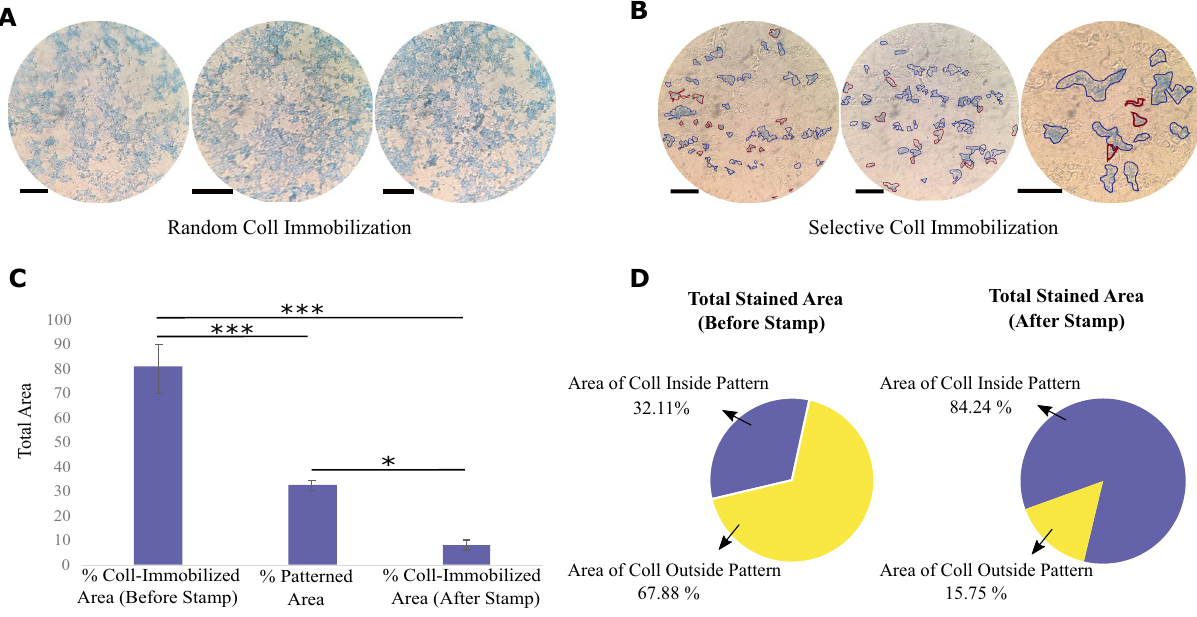
Figure 2. Coomassie brilliant blue staining of the aligned cell-imprinted PDMS surfaces ( A ) before and ( B ) after using the stamp method. Immobilized collagen inside the pattern with a blue border and outside pattern regions with a red border was marked (Scale bar = 80 μm). ( C ) The total area of the immobilized collagen before and after the stamp method compares with the total patterned area. ( D ) The ratio of immobilized collagen inside to outside of patterned regions before and after the stamp method. The area is measured by ImageJ software, and the graph represents the mean ± SD. *p value of < 0.05 and ***p value of < 0.001 between two groups (N =